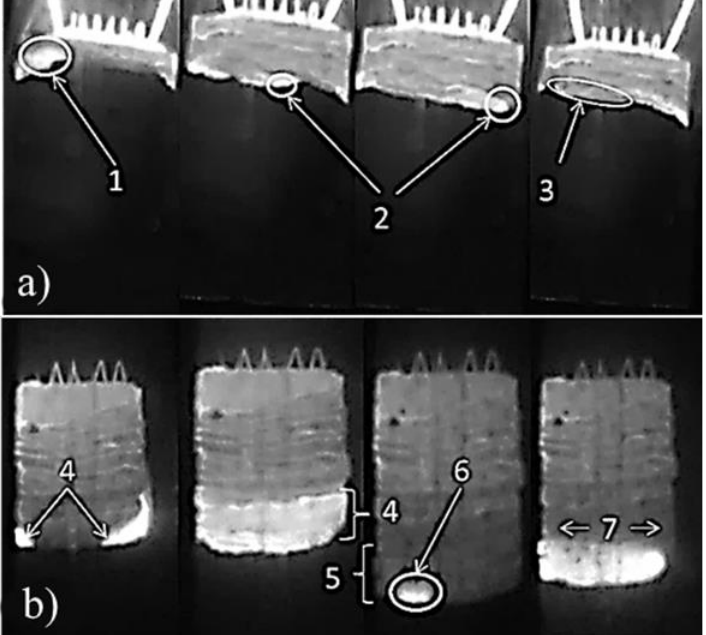
Figure 2. Image of the SHS process in the Al-Ti-B samples: ( a ) after 60 s and ( b ) after 900 s of mechanical